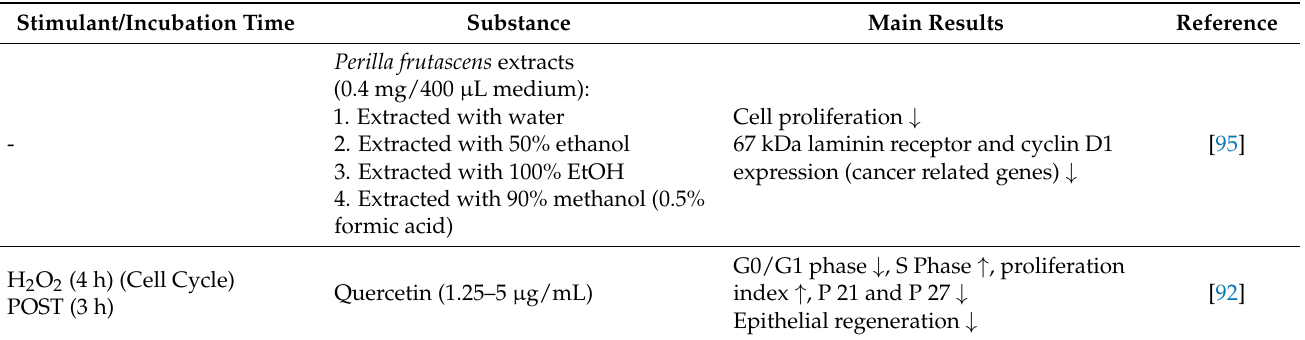
Table 5. Impact of PFA on proliferation of IPEC-J2 cells. Stimulant/Incubation Time Substance Main Results